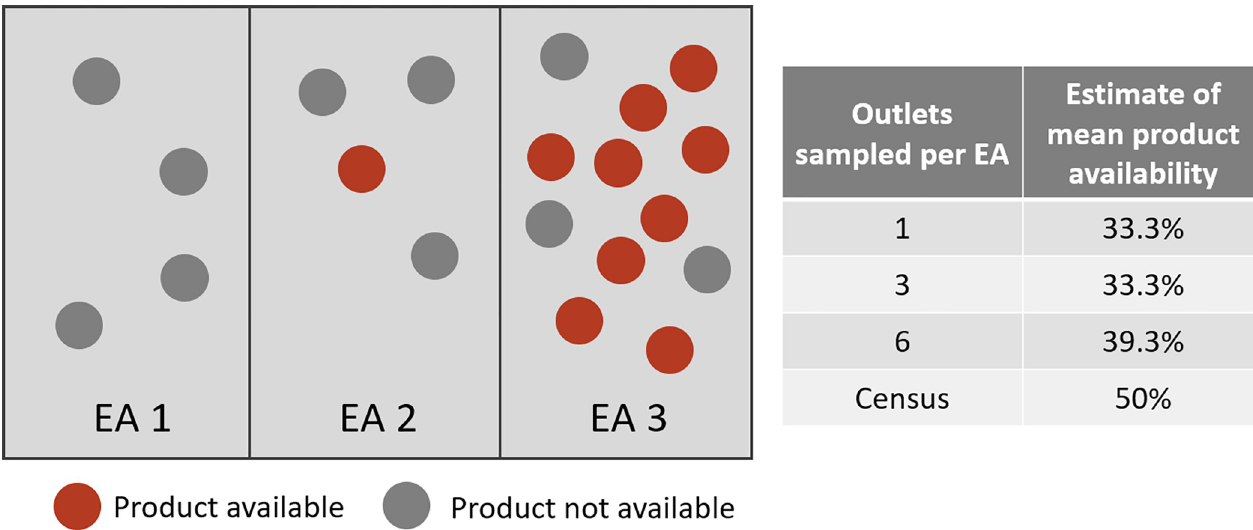
Fig 9. Stylized illustration of how bias may arise. In this stylized scenario, there are 20 outlets spread unequally across three enumeration areas. Product availability is 50% across all 20 outlets, but varies from 0% to 75% by EA. If samples of outlets are drawn from the universe of outlets in the EA, mean availability varies but can be consistently